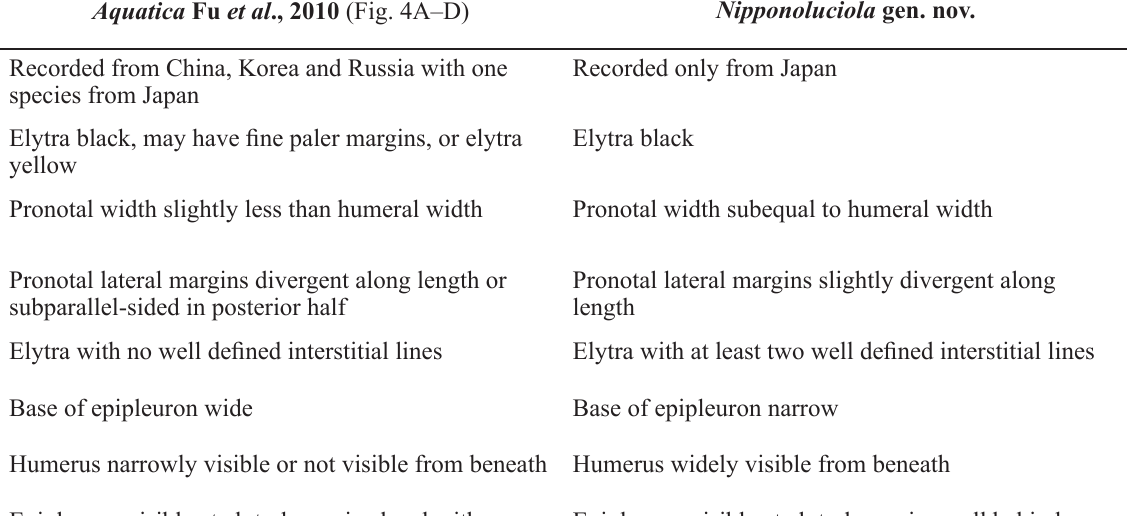
Table 2. Comparison of morphological features of Aquatica Fu et al ., 2010 and Nipponoluciola gen. nov. Aquatica Fu et al ., 2010 (Fig. 4A‒D) Nipponoluciola gen. nov